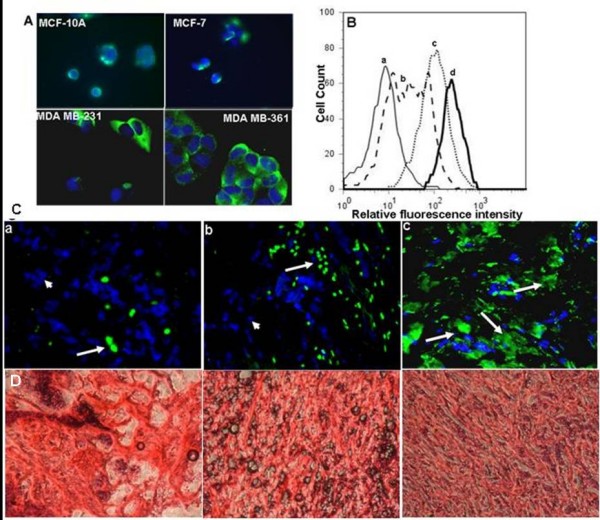
Localization and expression of BKCa channel protein. A: Immunofluorescence of breast cancer cell lines stained for BKCa channel (green) and nuclei with DAPI (blue). Expression of BKCa channel was strong in MDA-MB-231 and MDA-MB-361, weak in MCF-7 and indiscernible in MCF-10A. Stains were repeated twice. B: Flow cytometric detection of BKCa channel protein expression in various breast cell lines. Representative histograms from (a) MCF-10A, (b) MCF-7, (c) MDA-MB-231, and (d) MDA-MB-361 showing expression of BKCa channel protein. C: Immunofluorescence of anti-BKCa channels antibody on human breast cancer tissue. Antibody labeled in green (FITC), nuclei counterstained in blue (DAPI). (a) Very few cells show BKCa channels staining in the primary breast cancer tissue (n = 6, See large arrow). Note: Absence of green staining in most of the cells also indicates specificity of the antibody (See small arrows). (b) Systemic metastatic breast cancer (lymph node) shows an increased number of cells stained with BKCa channel antibody (n = 6; See large arrows). (c) All breast cancer tissue metastatic to the brain are strongly positive for the BKCa channels (n = 4). Magnification = 400×. D: Representative H&E staining of breast tumor tissue sections.